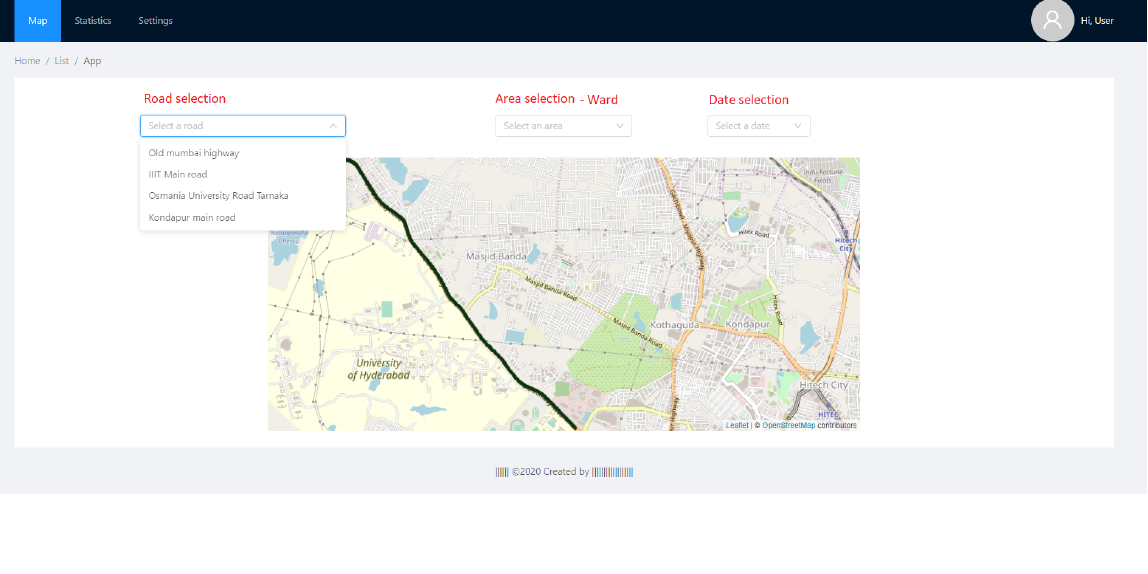
Figure 7. Snapshot of the visualization